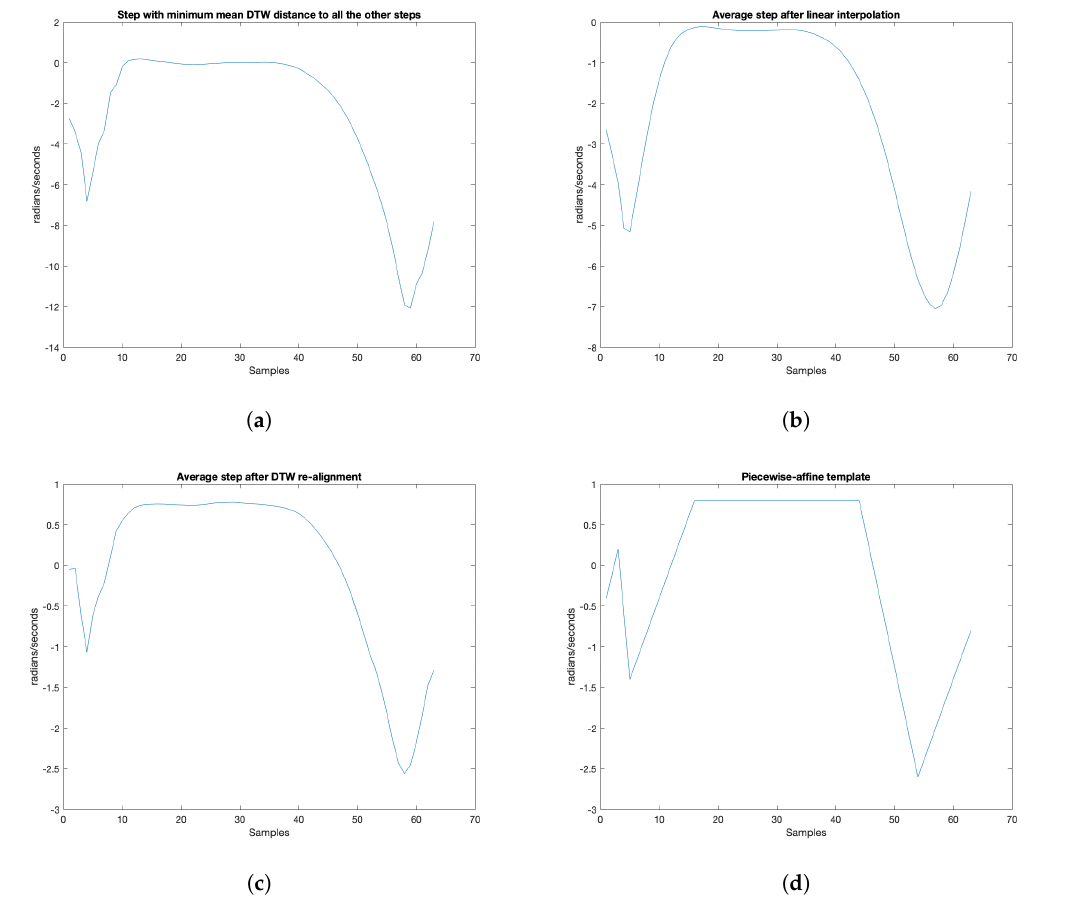
Figure 8. Learned templates for strategies S2, S3, S4 and S5. All templates contain 63 samples, which is the median length of the steps in the database. ( a ) Strategy S2: DTW-based selection; ( b ) Strategy S3: Linear fusion; ( c ) Strategy S4: Non-linear fusion; ( d ) Strategy S5: Knowledge-based